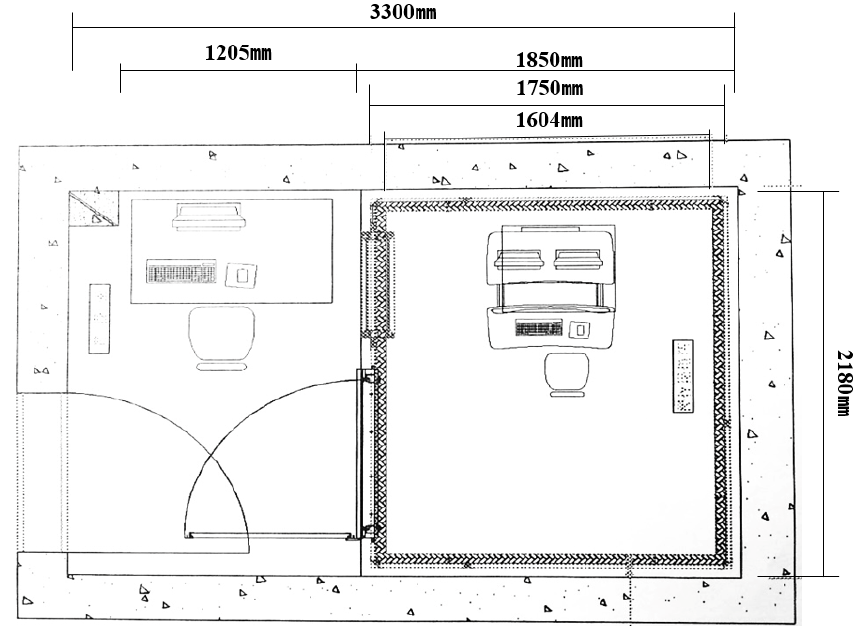
Figure 4. Control and shield room floor plans with Synamps2 (64-ch EEG equipment, Chung-Ang University).